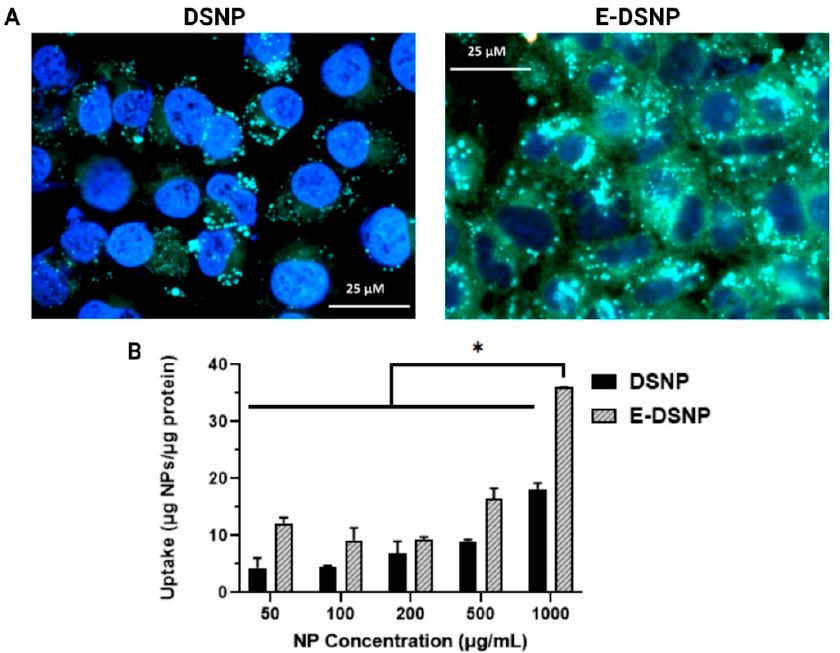
Figure 5. In vitro uptake of E-DSNPs. ( A ) Fluorescence imaging also observed significant enhance- ment in NP internalization of the anti-EphA2 tagged DSNPs or E-DSNPs ( right ) into A549 cancer cells compared to that of the untargeted DSNPs ( left ). Nuclei of the cells were stained blue with nucBlue ® dye. ( B ) Spectrophotometric analysis of E-DSNPs uptake into A549 cells showed dose- dependent uptake, in addition to nearly a fold-increase in NP uptake compared to untargeted DSNPs. (* Statistically significant with p < 0.05).